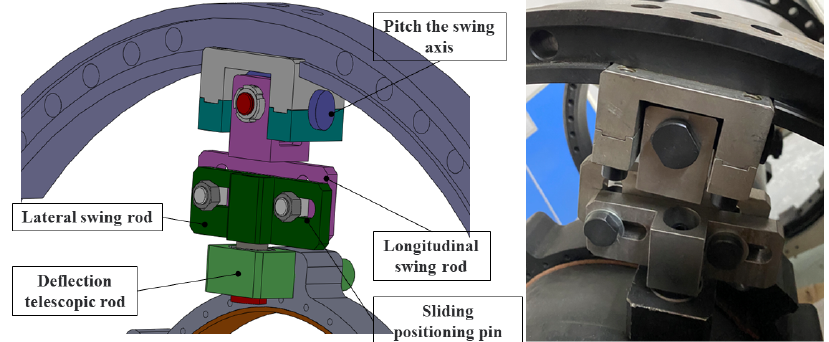
Figure 7. Adaptive clamping adjustment